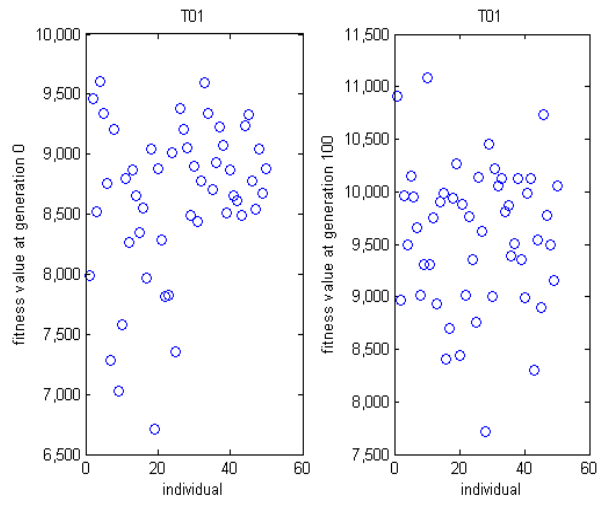
Figure 11. The distribution graph of fitness on MSO4 for S01.